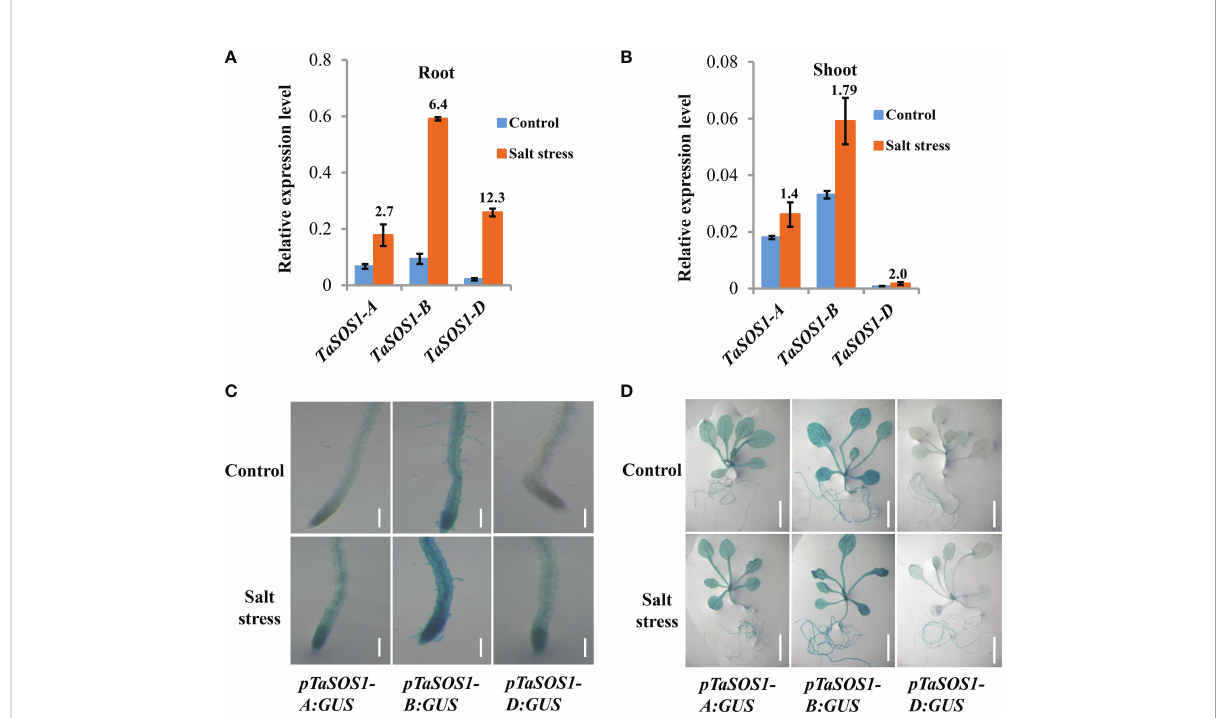
FIGURE 5 Expression patterns of three TaSOS1 homoeologous genes in response to salt stress in allohexaploid wheat. (A, B) Transcript levels of three TaSOS1 homoeologous genes in roots and shoots of allohexaploid wheat upon NaCl treatment. qRT-PCR analysis the expression of TaSOS1-A , TaSOS1-B and TaSOS1-D genes with gene-speci fi c primers in wheat seedling roots that subjected to 9 h treatment with 200 mM NaCl or in wheat seedling leaves subjected to 2 d treatment with 200 mM NaCl. Fold change ratio was labeled above the bars. The expression of b -Actin was used to normalize mRNA levels. The values are means (± SE) of three biological replicates. (C, D) Spatial expression patterns of the TaSOS1- A , TaSOS1-B and TaSOS1-D genes in transgenic Arabidopsis plants harboring their promoters fused to the GUS gene, respectively. Promoter activity was visualized through histochemical GUS staining in roots (C) and seedlings plants (D) transferred to normal medium (control) or to medium containing 200 mM NaCl (salt stress) for 1 days. Scale bars: root, 200 µm; whole seedling plants, 1